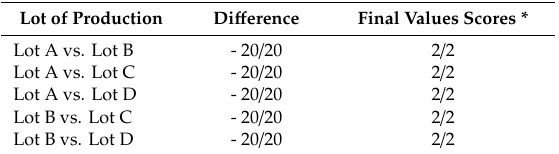
Table 8. Sensorial evaluation by not trained